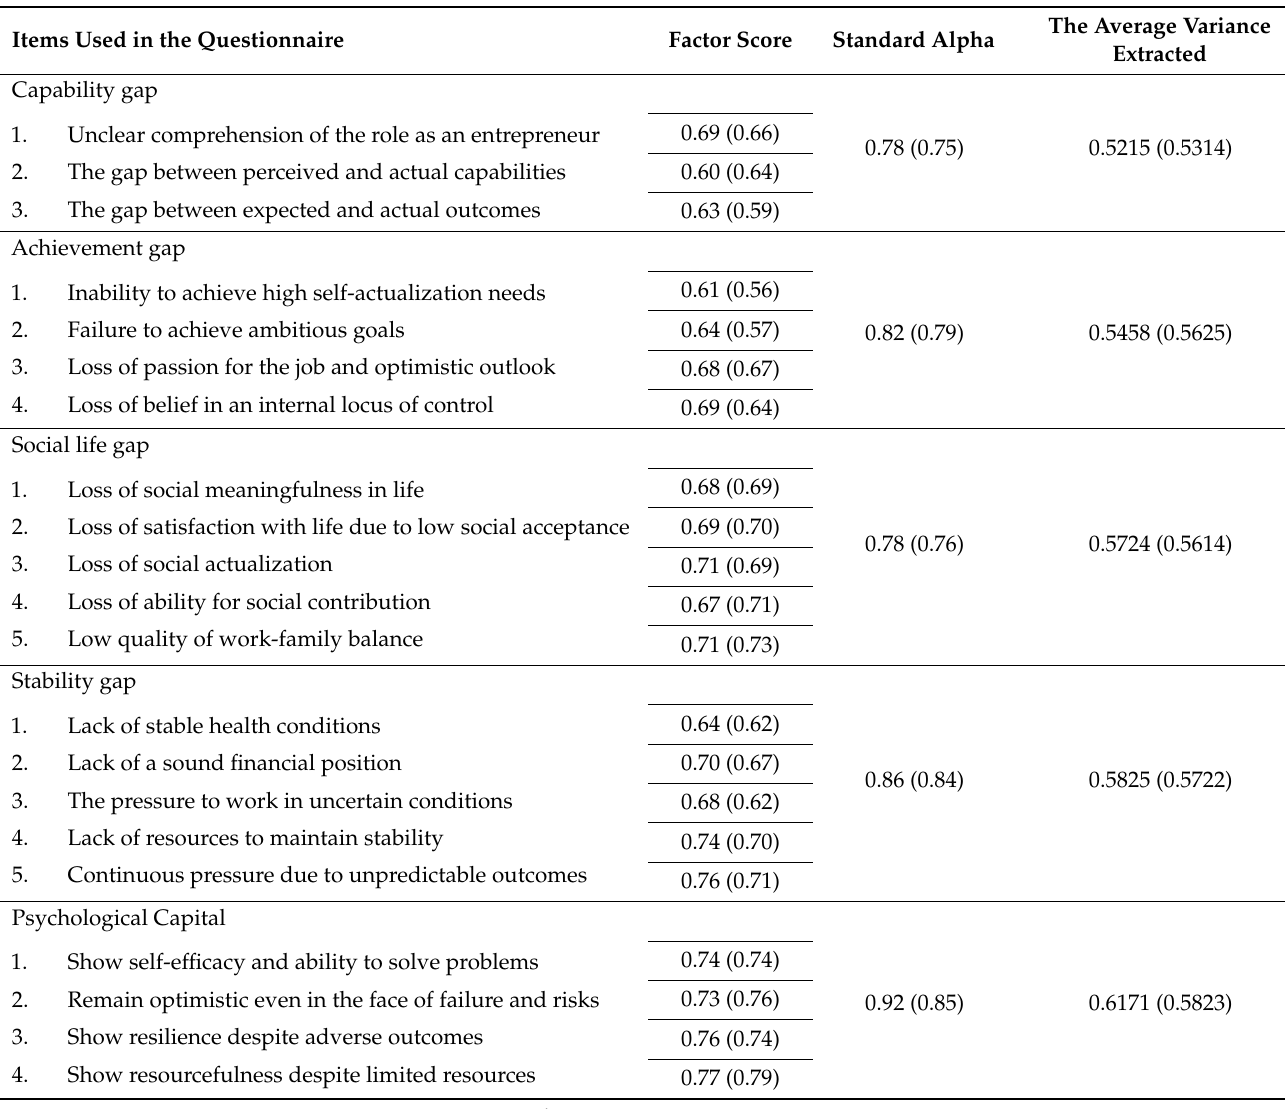
Table 4. Factor loadings, alpha scores, and average variance extracted